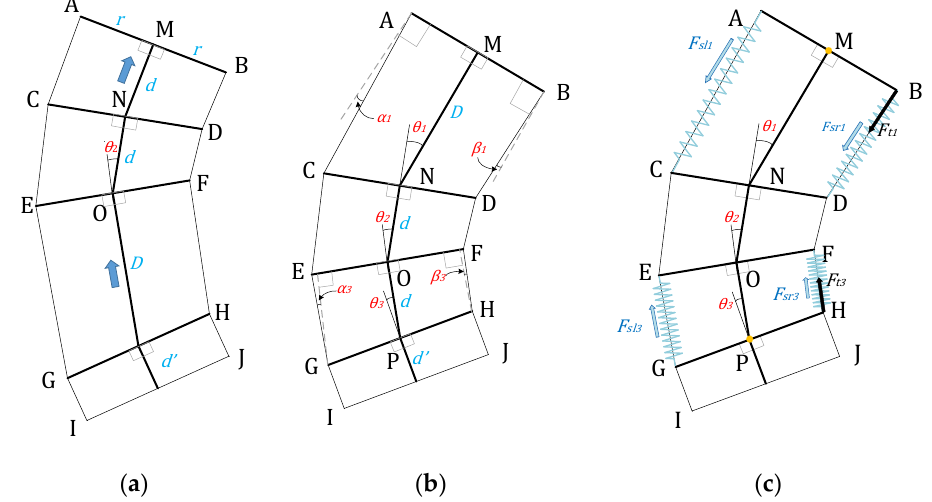
Figure 7. The solenoid valves’ control signal during the motion cycle of the robot. As shown in Figure 4, valves 1 – 3 control the pressure in suction cups, and valves 4 – 9 control the pressure in the cylinders of segments 1 – 3. If the solenoid valve receives high potential, the cylinder will be connected to the air pump, and if it’s low potential, the cylinder will be connected to the atmosphere.